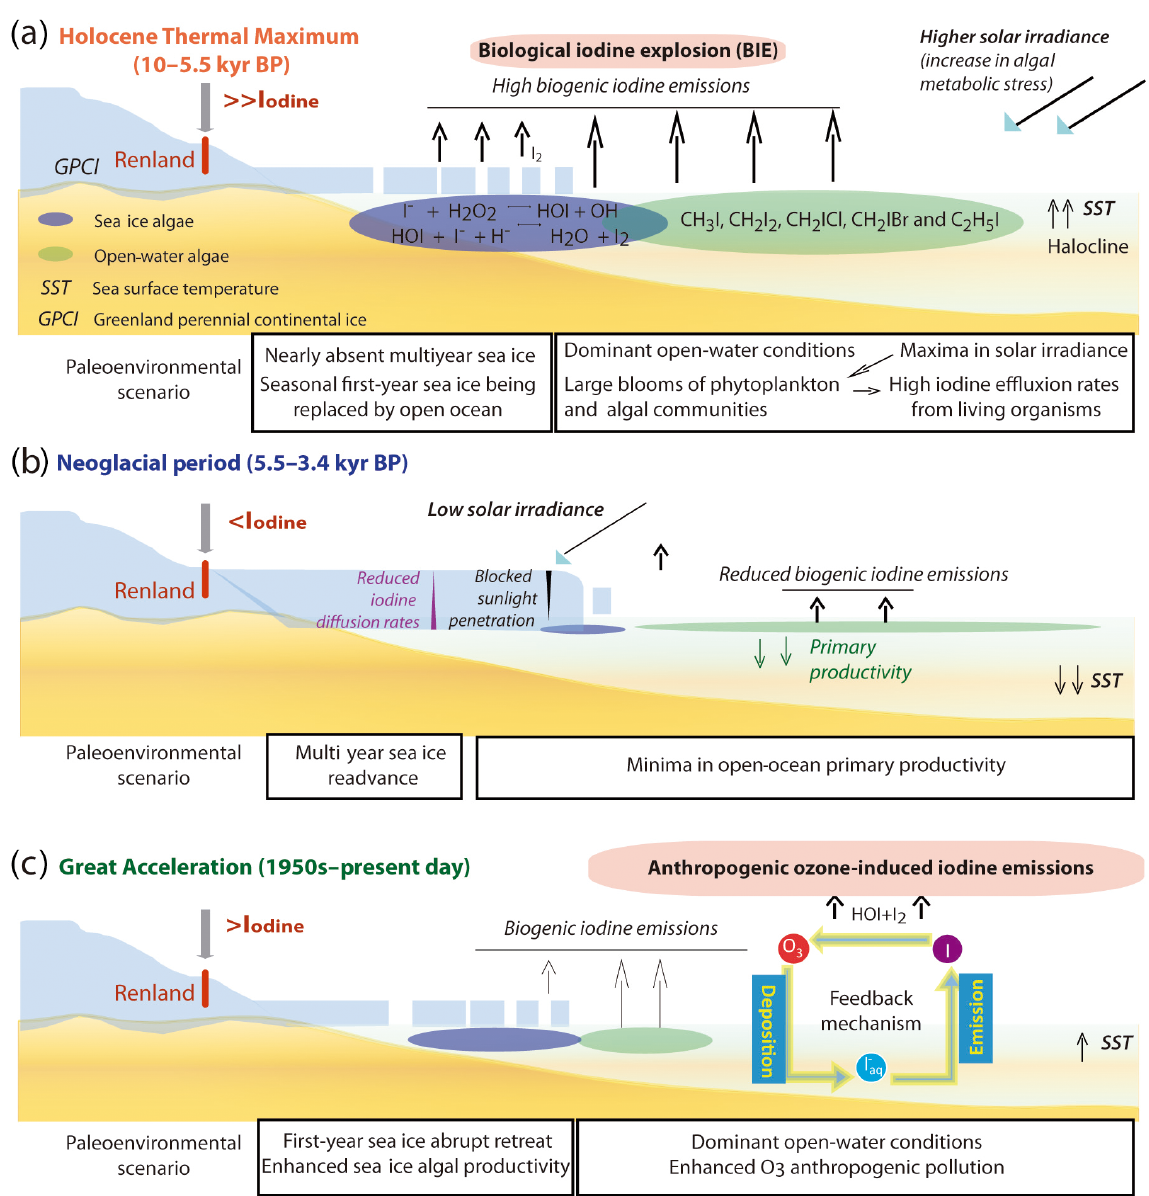
Figure 3. Schematic diagram showing the coupled ocean–atmosphere iodine biogeochemical cycle throughout the Holocene. (a) Holocene Thermal Maximum. (b) Neoglacial period. (c) Great